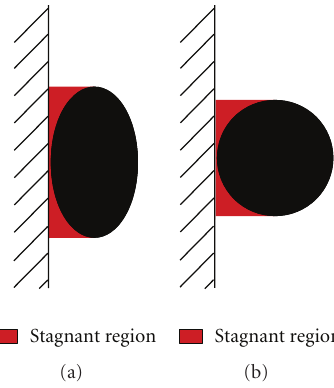
Figure 4: Deformation of (a) 12 mm and (b) 14 mm Buna-N O-